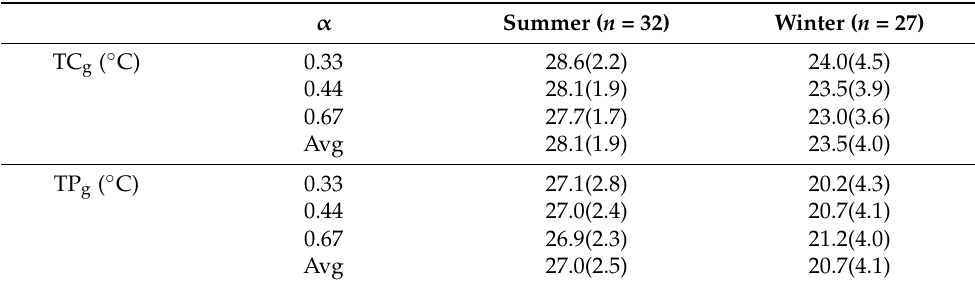
Table 7. Average comfort air temperature calculated using the Griffiths method.